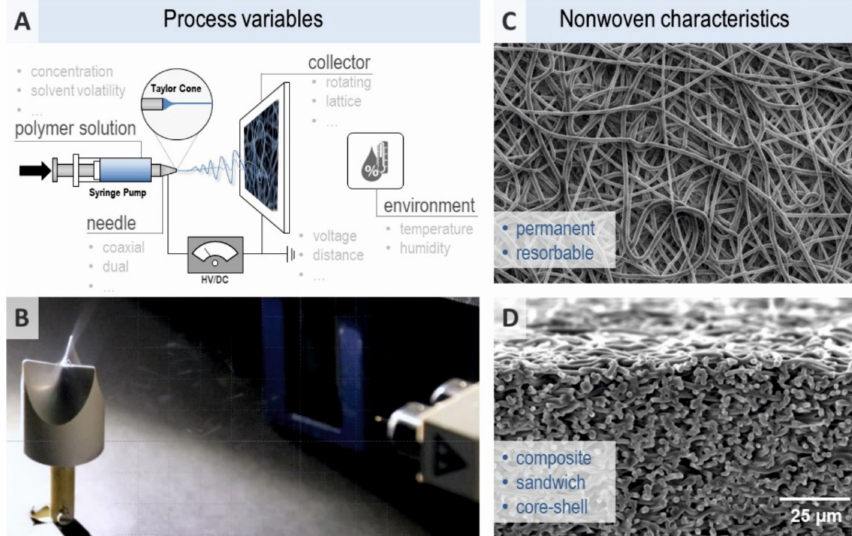
Figure 4. ( A ) Schematic of the electrospinning (ES) principle, ( B ) Macrograph of dual ES for 3D heart valve replacement, ( C ) SEM image, demonstrating the highly porous surface morphology of an ES nonwoven sample, ( D ) Cross-sectional SEM image, demonstrating the compact bulk architecture and pronounced interfibrous integrity of the ES